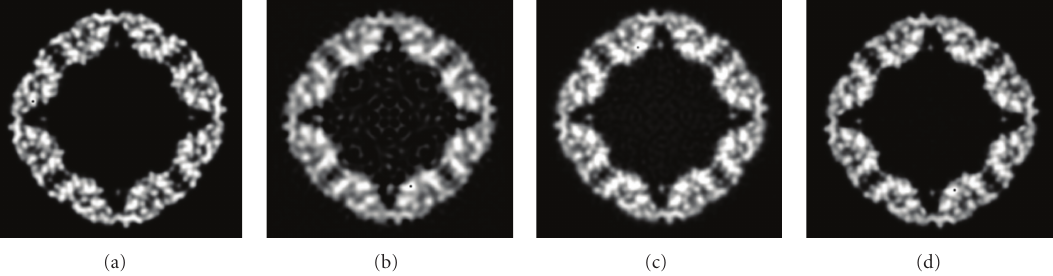
Figure 5: Maps of two-dimensional sections perpendicular to Z axis with Z = 0 of the erythrocyte L Ferritin model and reconstruction results viewing along the 3-fold axis by the DSAF method: (a) the standard model, (b) the reconstructed results with S/N = 0 . 1, (c) S/N = 0 . 5, (d) S/N = 0 . 8.